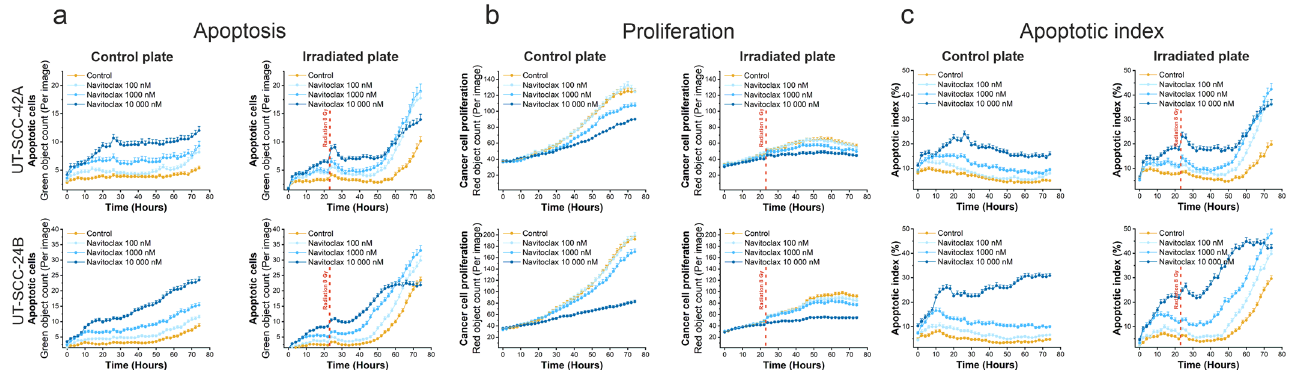
Figure 4. The navitoclax–irradiation combination triggers apoptosis and halts proliferation in HNSCC cells. The live cell apoptosis assay was performed for two cell lines (UT-SCC-42A and UT-SCC-24B). Cancer cells were labeled with CellTrace Far Red and the IncuCyte Caspase-3/7 Apoptosis Assay Reagent (green) was applied to detect apoptotic cells. Cells (1000 per well) were seeded to two plates and treated with three navitoclax concentrations (100, 1000 and 10,000 nM). The control group was treated with 0.1% DMSO. One of the plates was irradiated (8 Gy) after 24 h. Plates were imaged using the Incucyte S3 imaging system for a total of